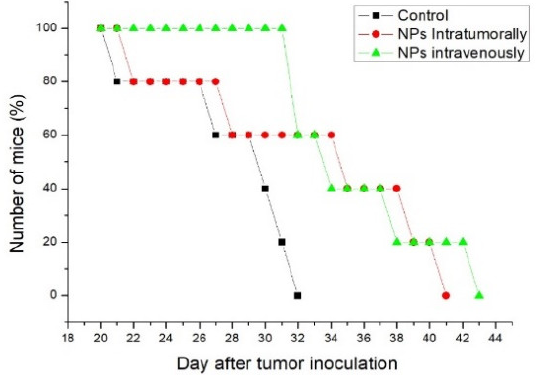
Figure 42. Number of living mice with Lewis lung carcinoma tumor after intratumoral (red circles) and intravenous administration (green triangles) of Si NPs with 0.2 at% of iron impurities and for the control group (black squares) vs time after tumor inoculation. (Reprinted from Reference [103] by permission from World Scientific Publishing © 2020).